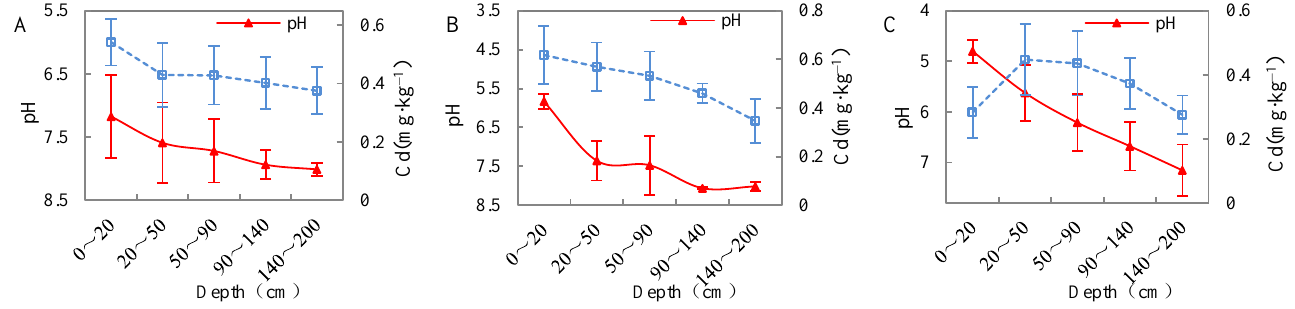
Figure 8. Box plots of soil cadmium content -pH ( A ) and cadmium content -SOM ( B ) at different depths along the deep soil profile.